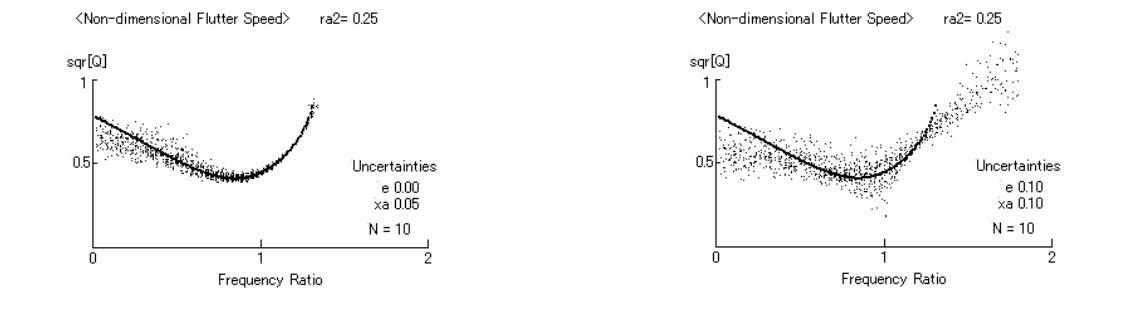
Fig 6. Boundary with uncertainty of 10% in both parameters